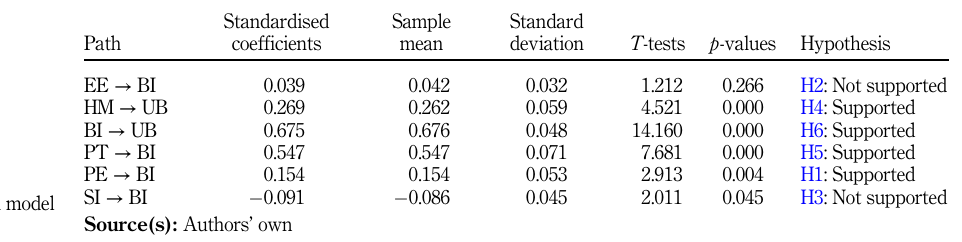
Figure 1. The structural equation modelling results